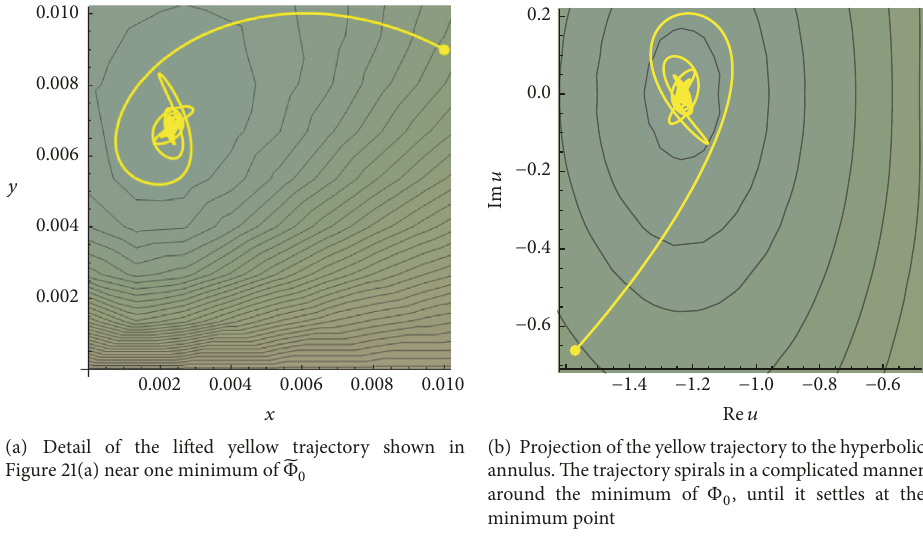
Figure 22: Detail of the yellow trajectory shown in Figure